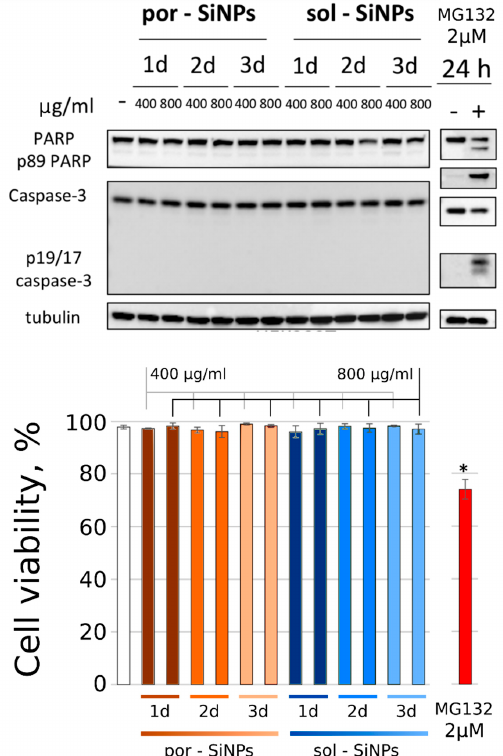
Figure 4. Western blot analysis of total cellular lysates from HEK293T cells upon treatment with two types of nanoparticles (por-SiNPs and sol-SiNPs) and positive control for apoptosis induction– MG132. Tubulin was used as a loading control. Designations: PARP–full form and p89 fragment of PARP; Tubulin–alpha-tubulin; p19/17 caspase-3–p19/17 fragments of caspase-3; h–hours, d-days. B– The histogram of flow cytometry (FC) analysis data for HEK293T cells treated with these nanopar- ticles at different concentrations and MG132 (2 μ M). All experiments were performed at least three times. Results are presented as mean +/ − standard deviation (SD). * p < 0.05: significant difference compared to control cells (Mann–Whitney U test). A broad-spectrum protein kinase inhibitor, Staurosporine (STS), in concentration 0.25 μ M for 4 h and a proteasome inhibitor MG132 in concentration 2 μ M for 24 h were